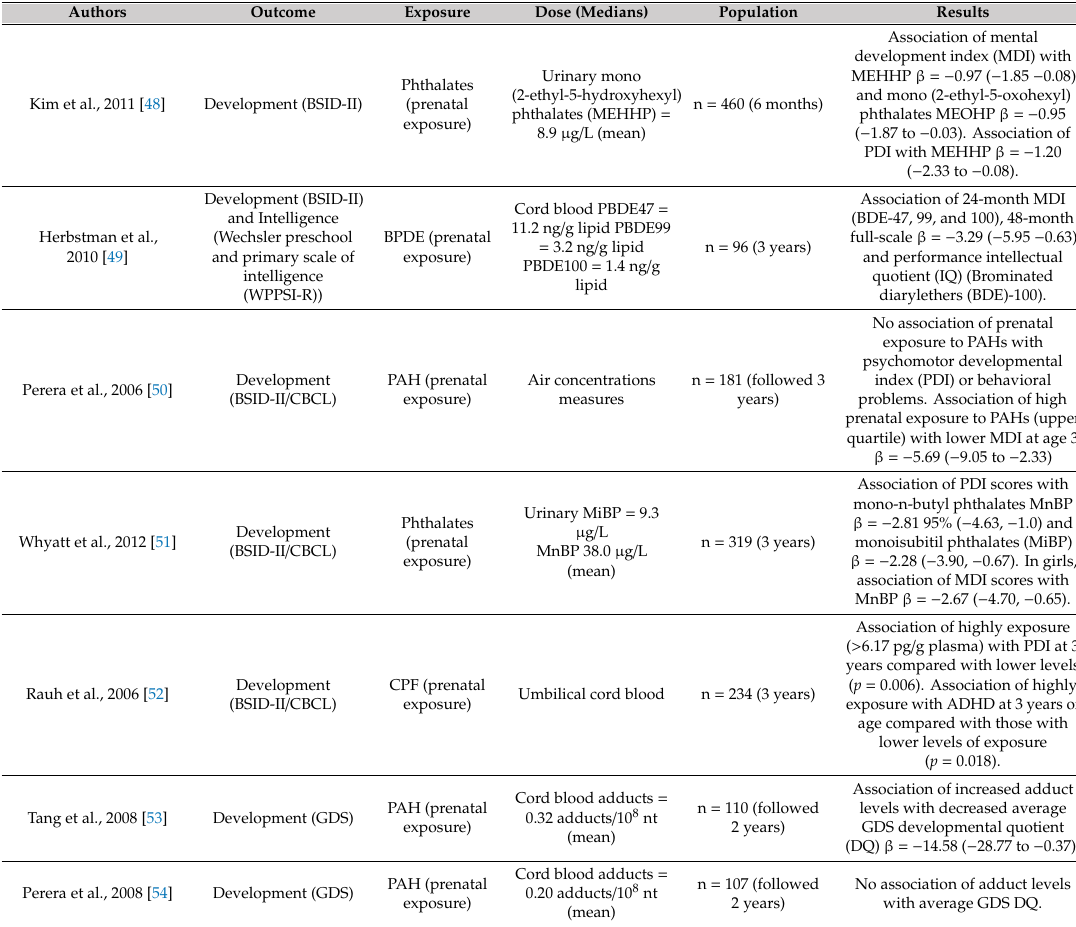
Table 3. Endocrine disruptors and global developmental